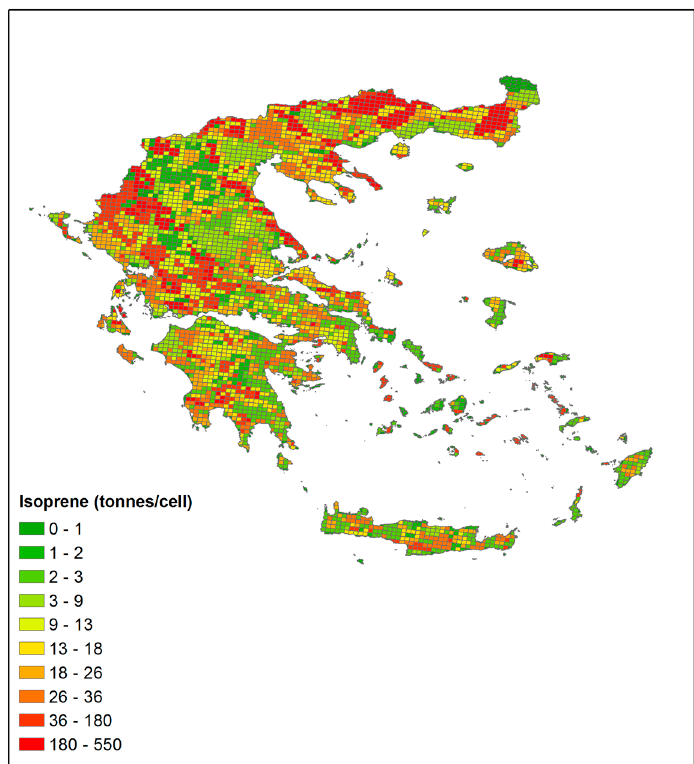
Figure 3. Spatial distribution of total annual isoprene emissions over Greece.